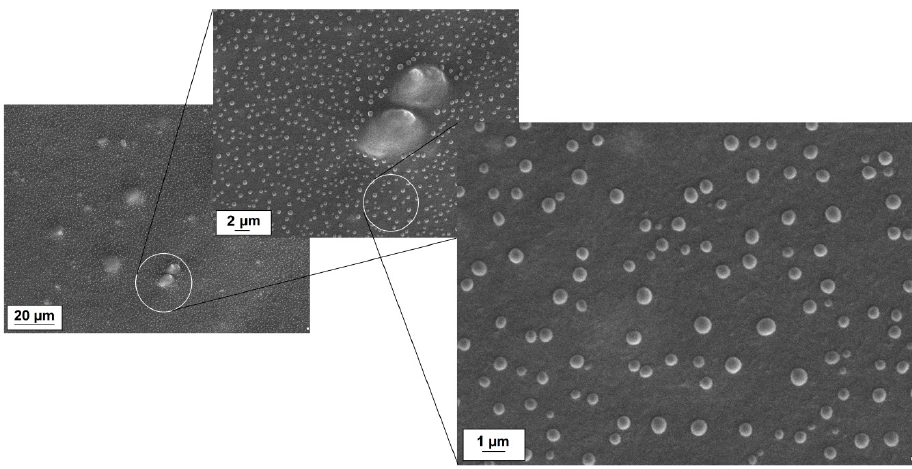
Figure 5. SEM images of the LDPE/MgO-L (1:5 wt./wt.) composite.